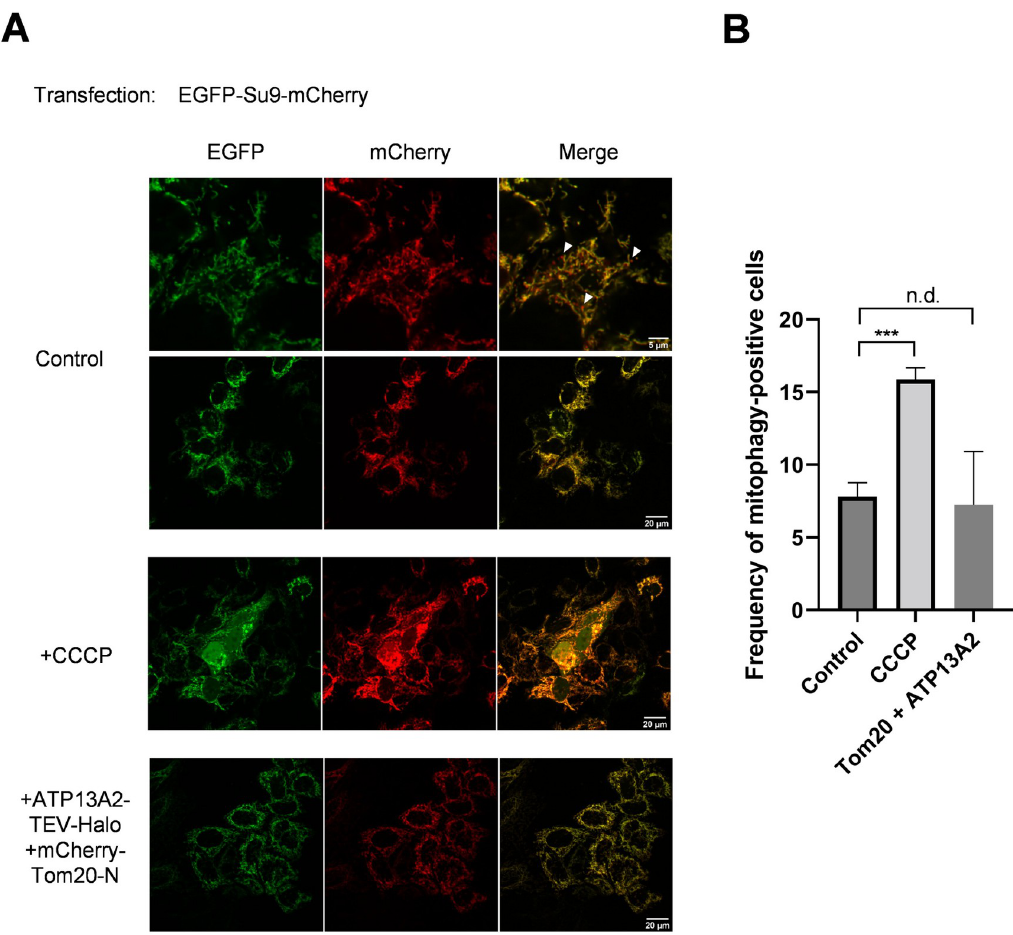
Fig 5. The number of mitophagic cells is not affected by co-expression of ATP13A2-Halo and Tom20. HeLa cells stably overexpressing ATP13A2-Halo were additionally transfected with plasmids carrying Tom20 and Su9-mCherry-GFP. Two days after transfection, the cells were analyzed by confocal microscopy. The mitophagic cells are defined as those exhibiting mCherry- positive and GFP-negative particles. White arrow heads indicates representative mitophagic particles. As a positive control condition, cells were treated with 50 μ M 3-chlorophenylhydrazone (CCCP). (B) The numbers of mitophagic cells were counted and shown as frequencies (%). Values are average ± S.E.M. (n = 50 cells). Statistical analysis was performed using Student’s t test: � p < 0.05, �� p < 0.01, ��� p < 0.001, “n.d.” difference is not